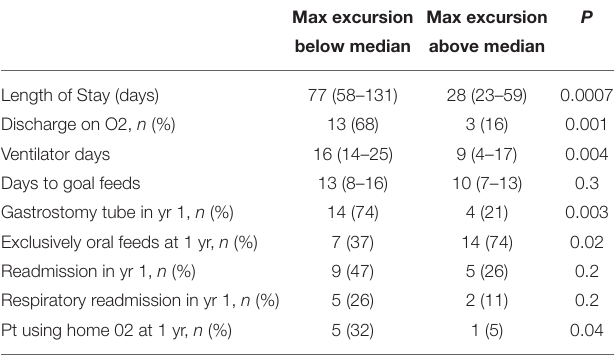
TABLE 3 | Relationship between maximal excursion ratio and clinical